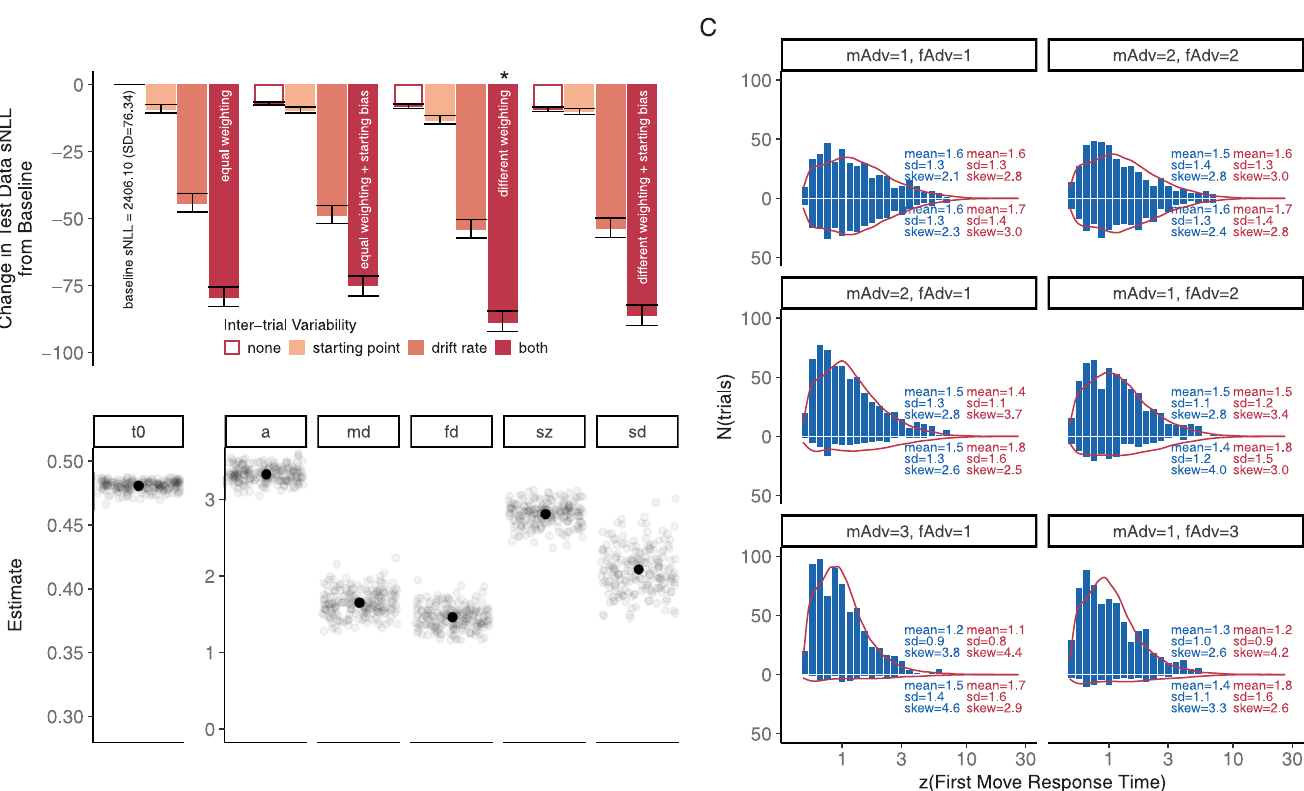
Fig 4. Weighted integration of myopic and future constraints in initial-step decision making in the base task. A. Test data objective (summed negative log- likelihood) of candidate drift-diffusion models, as marked on dark red bars, as compared to the baseline model (see text for details). Asterisk marks the winning model. B. Parameter estimates of the winning drift-diffusion model. t 0 , non-decision time. a , decision bound. md and fd , myopic and future advantage weights. sz , inter-trial variability of the starting point. sd , inter-trial variability of the drift rate. C. Predicted response time (RT) distributions (in red, sampled from the parameter estimates of the winning fit in the fold with the best test objective) and the empirical RT distributions (in blue). In C., the top two panels show the RT distributions associated with choices satisfying the myopic advantage on the top and those satisfying the future advantage on the bottom. The bottom four panels show the RT distributions for the correct responses on the top and error responses on the bottom. mAdv, myopic advantage. fAdv, future advantage. All error bars indicate 95% bootstrapped confidence limits.